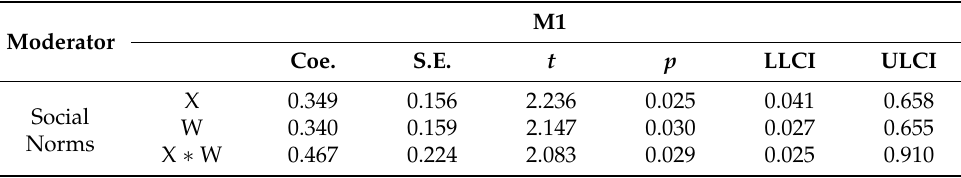
Table 2. The moderating role of social norms (1).